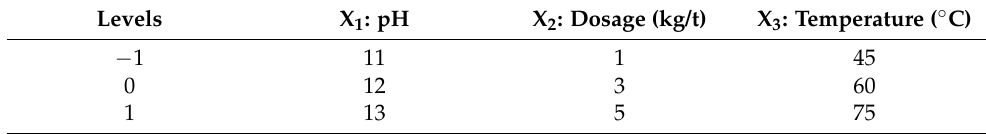
Table 3. Selected ranges for coded and actual values of the independent variables. Levels X 1 : pH X 2 : Dosage